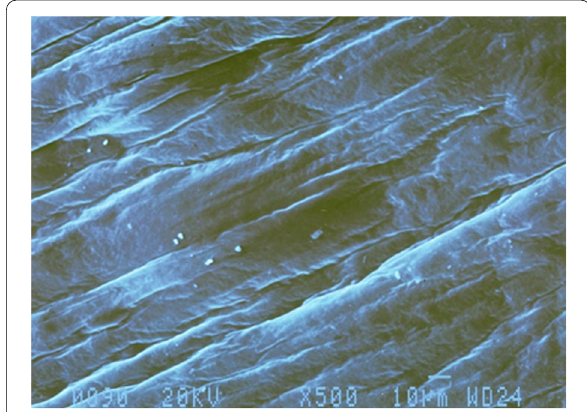
Fig. 5 Scanning electron micrograph showing the morphology and microstructure of recombinant BC produced by E. coli DH5α at 500 times